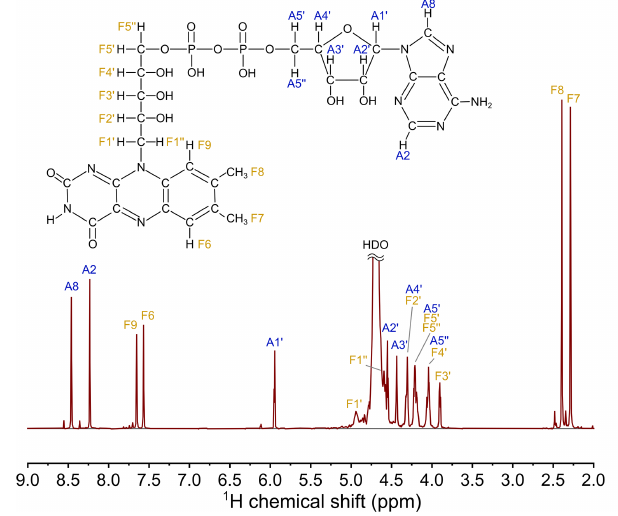
Figure 2. The 700MHz 1 H NMR spectrum of 4.2mM FAD solu- tion in D 2 O, pH 2.7, 25 ◦